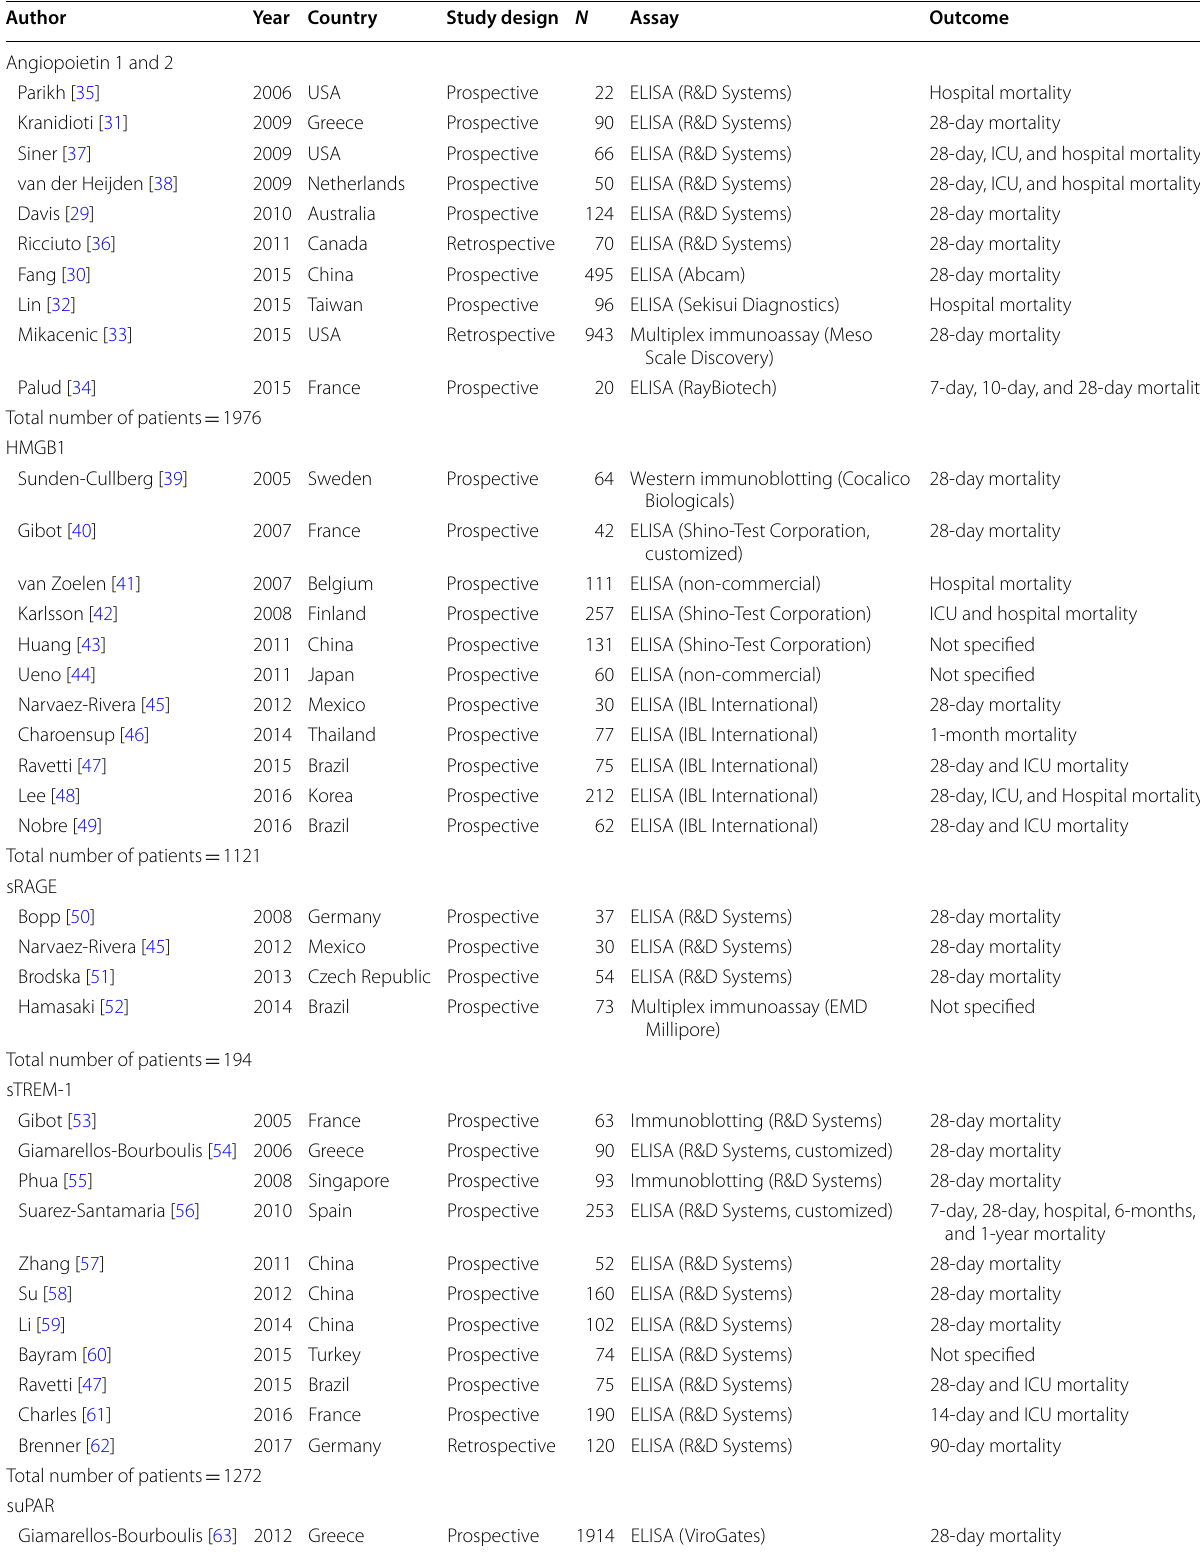
Table 1 Characteristics of all included